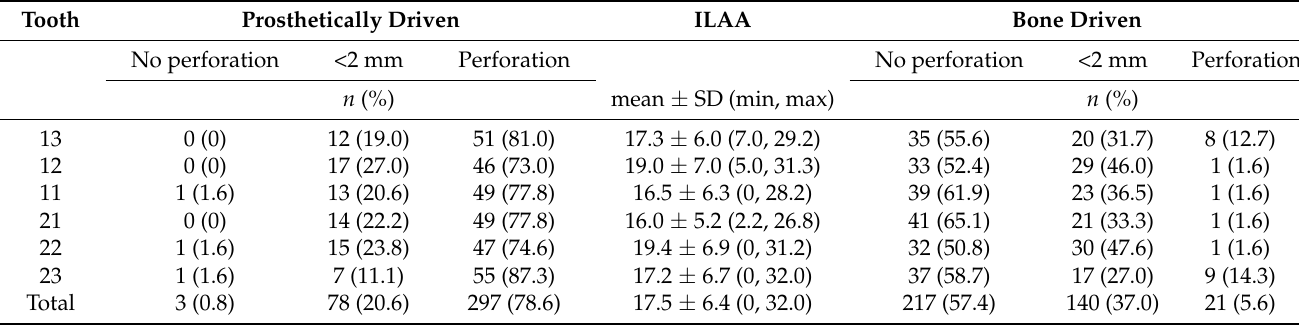
Table 5. Frequency of cortical bone perforation for 3.0/3.75 mm implants, for both prosthetically- and bone-driven positions, and the ILAA.